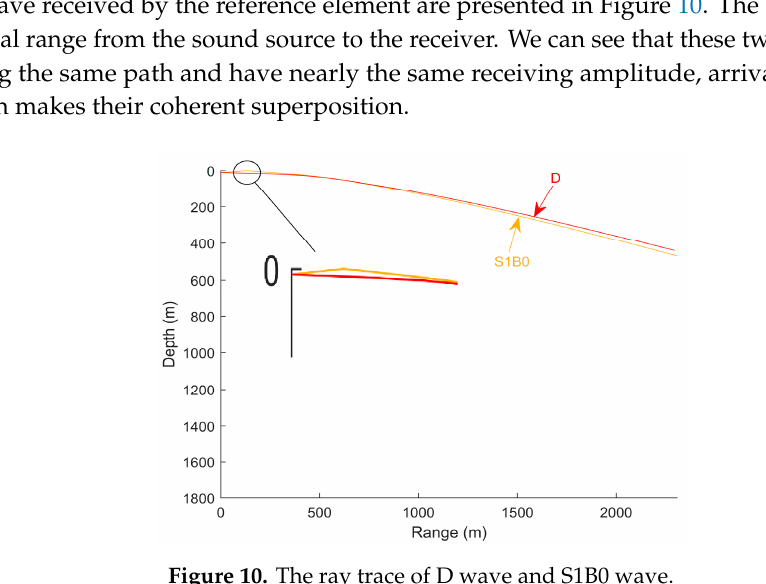
Figure 10. The ray trace of D wave and S1B0 wave.